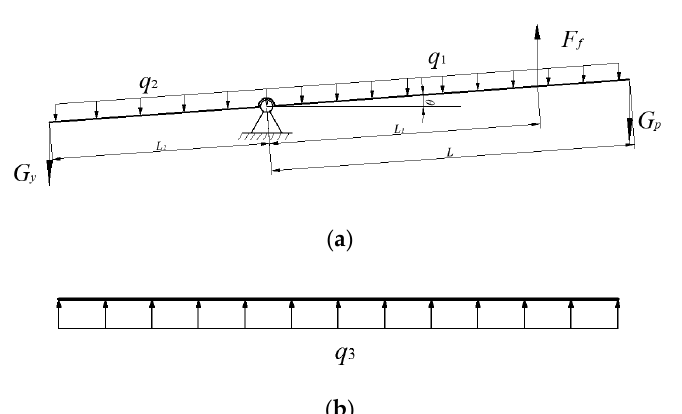
Figure 3. Lifting Arm System Structure.